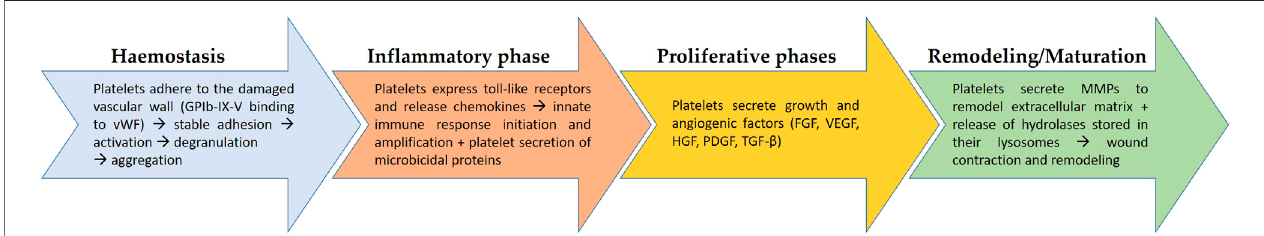
FIGURE 1 | The role of platelets in the different sequential steps of wound healing. In wound healing, four steps are recognized, i.e., hemostasis, in fl ammation, proliferation, and remodeling/maturation. From the beginning of the process platelets play a fundamental role, starting from the aggregation and formation of a clot to stopbleeding(hemostasis).Theyalsocontributetotherecruitmentofimmunecells(in fl ammatoryphase),totheformationofgranulationtissue(proliferativephase),tothe remodeling and contraction of the wound to reconstitute structural continuity and, possibly, function. vWF, von Willebrand factor; FGF, Fibroblast Growth Factor; VEGF, Vascular Endothelial Growth Factor; HGF, Hepatocyte Growth Factor; PDGF, Platelet-Derived Growth Factor; TGF- β , Transforming Growth Factor β ; MMPs, Matrix